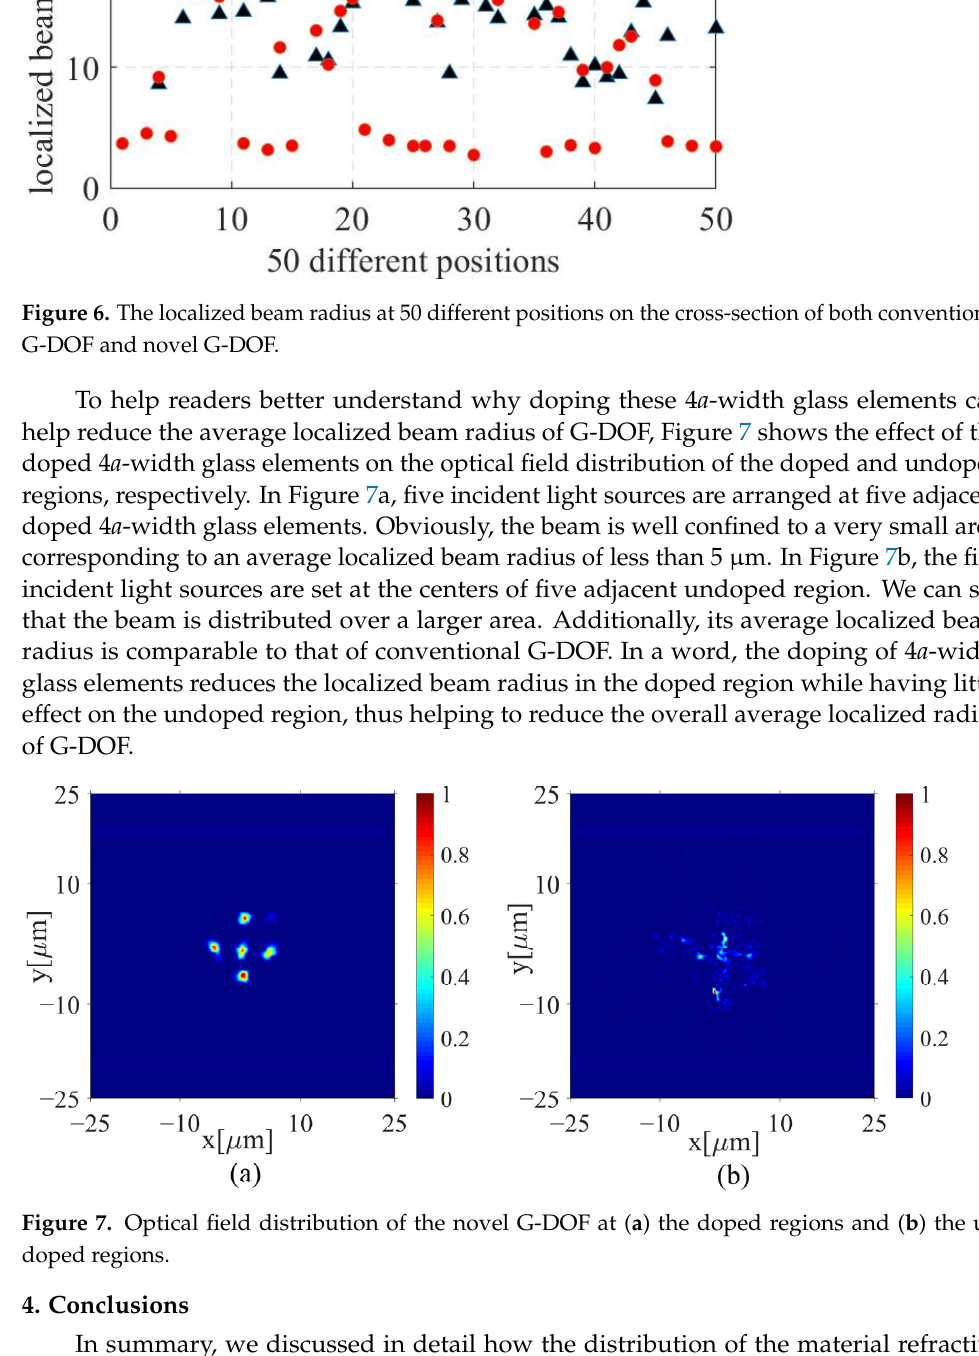
Figure 7. Optical field distribution of the novel G-DOF at ( a ) the doped regions and ( b ) the undoped regions.